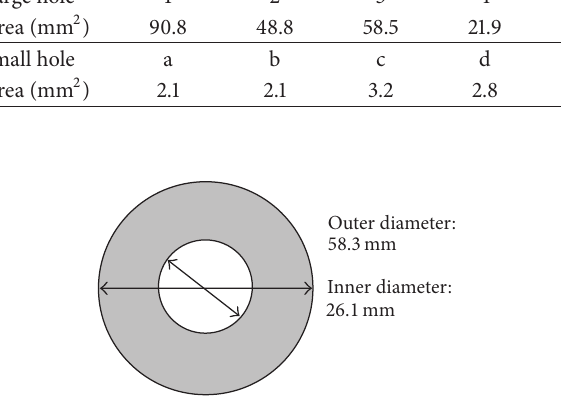
Figure 3: A cylindrical cross section of the same area and porosity of the lotus